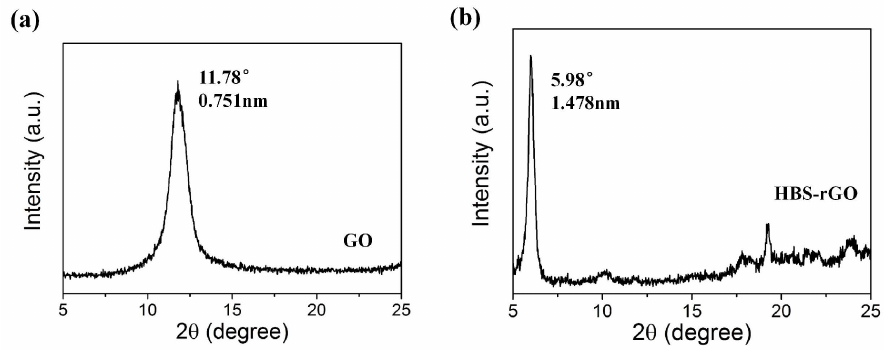
Figure 3. The X-ray diffraction (XRD) patterns of ( a ) GO and ( b ) HBS-rGO.